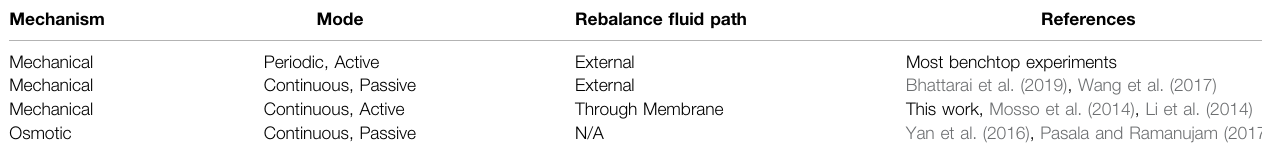
TABLE 1 | Methods to manage bulk volume imbalance between reservoirs in redox fl ow batteries. Mechanism